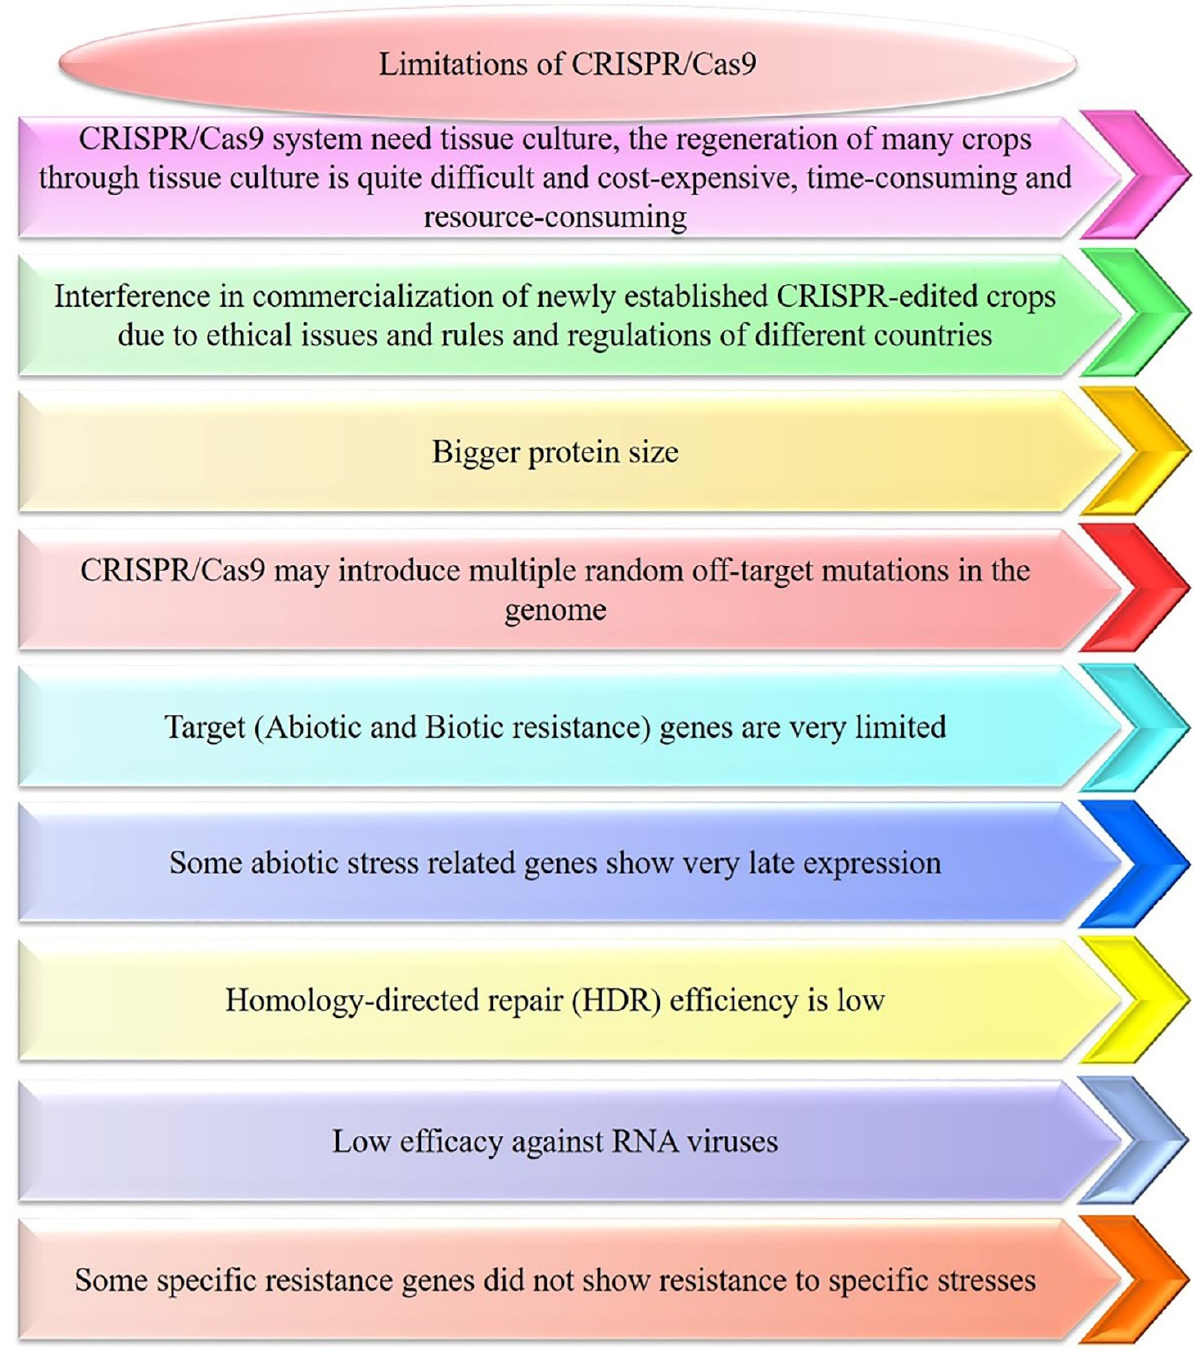
Figure 4. Limitations of the current CRISPR/Cas system. Using the CRISPR/Cas system in plants requires Agrobacterium tumefaciens -mediated transformation, but it is a time-consuming, cost-intensive, and laborious process. The selection of target genes is very limited. On the one hand, the function of resistance genes is redundant, and knocking down a gene alone cannot achieve resistance. Conversely, the knockout of resistance genes is restricted by PAM, and sequences close to PAM must be selected. CRISPR/Cas may introduce random off-target mutations in the plant genome. The commercialization of CRISPR-edited crops has been disrupted as Cas proteins take many generations to be completely isolated and obtain transgene-free crops. Currently, the homologous recombination pathway (knock-in/gene replacement) is less efficient, and the efficiency of homologous donor sequence transformation into plant cells is low, resulting in low difficulty and efficiency of knock-in. Therefore, the use of CRISPR/Cas-mediated homologous recombination in plants still has a long way to go for efficient gene knock-in.